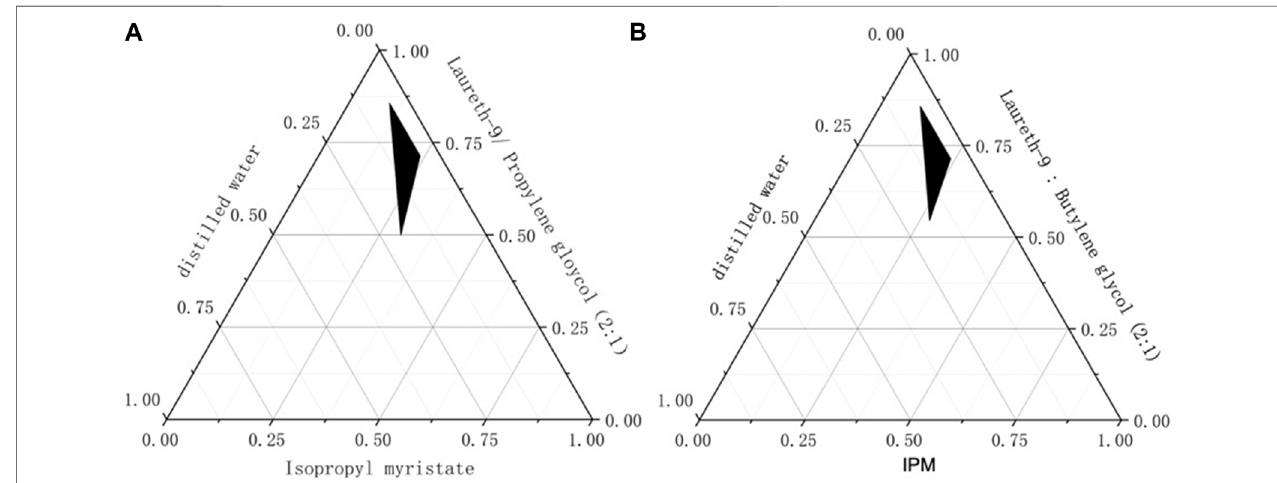
FIGURE 1 | The pseudo-ternary phase diagrams for co-emulsi fi er (A) : Propylene glycol as the co-emulsi fi er (B) : Butylene glycol as the co-emulsi fi er.